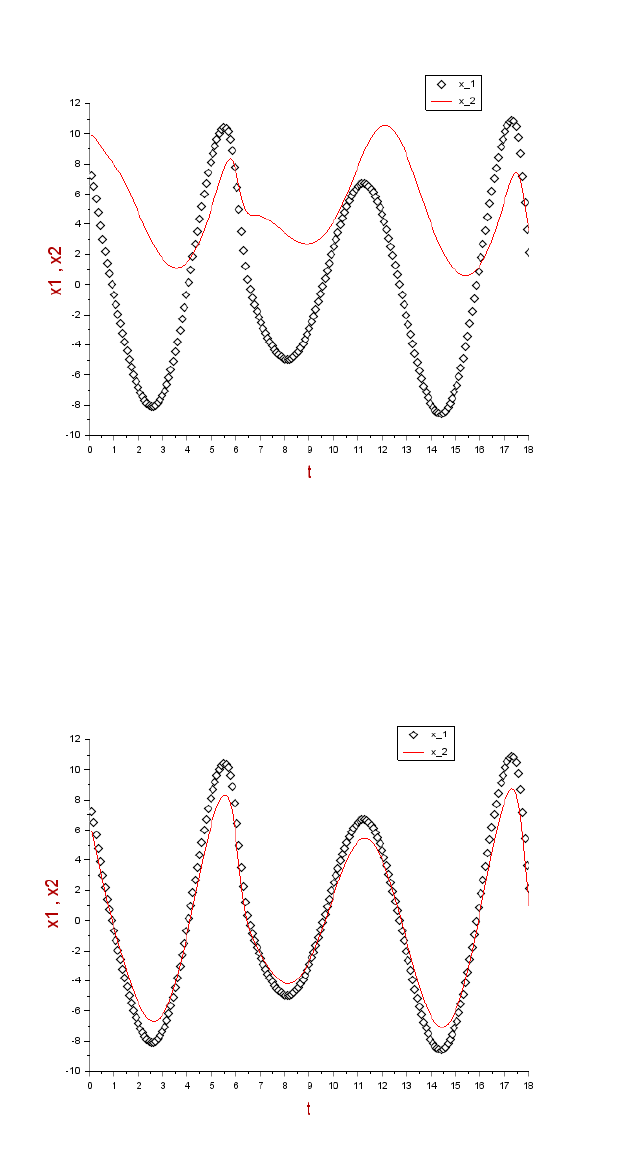
Figure 1. The chaotic attractor of the R¨ossler and Lorenz systems: x 1 x 2 - plane projections.